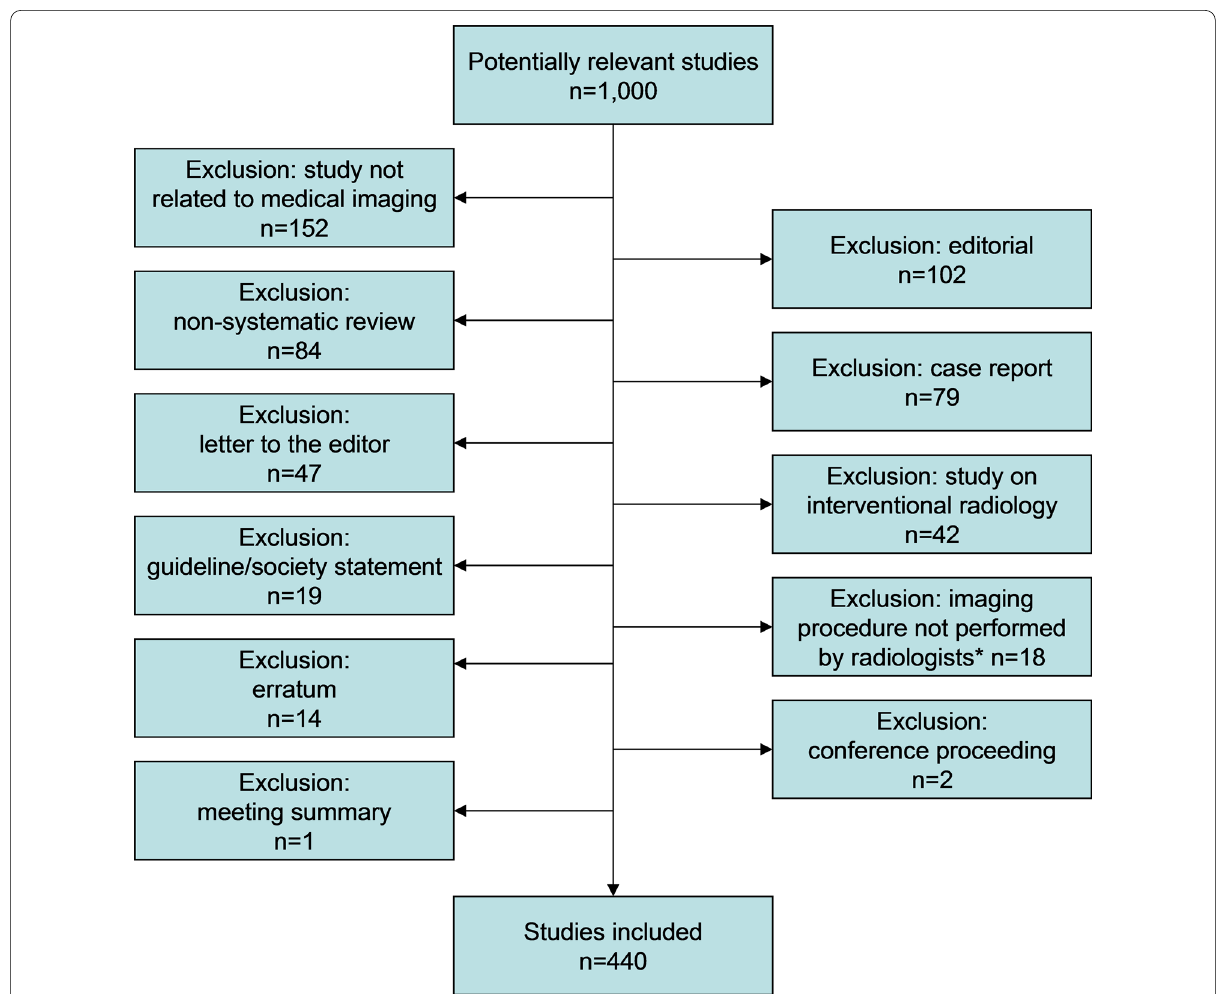
Fig. 1 Flow diagram of the study selection process. Notes :*in the authors’